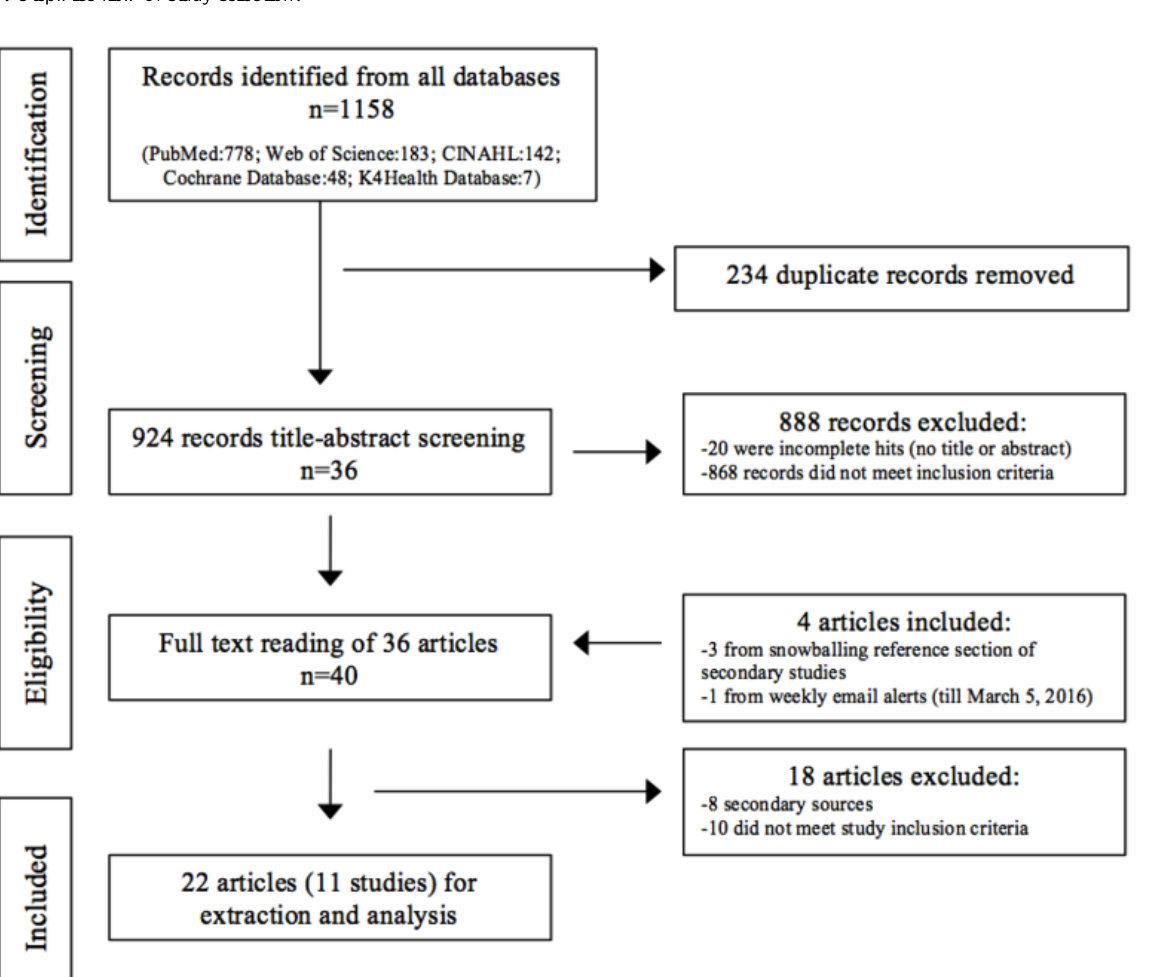
Figure 1. Stepwise flow of study